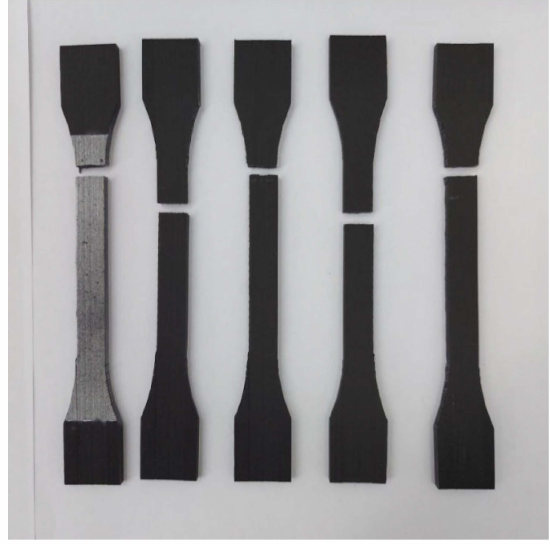
Figure 14. Failure mode of the XY